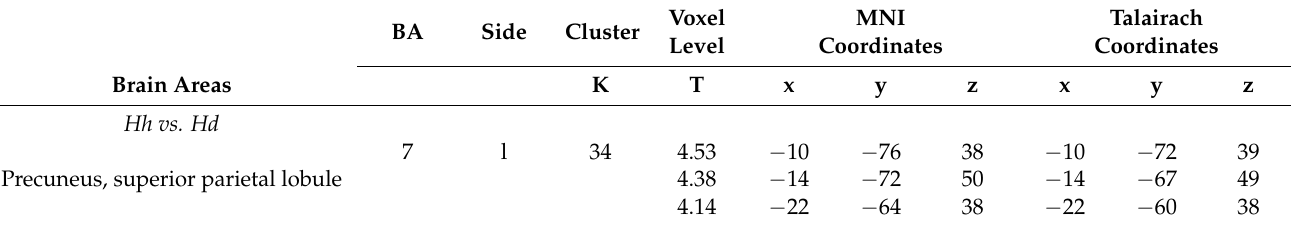
Areas of significant correlation with EC scores for the contrast “posing happiness and perceiving happiness” vs. “posing happiness and perceiving disgust”; BA = Brodmann area; l = left; r = right; cluster size threshold k > 30, corrected at α <